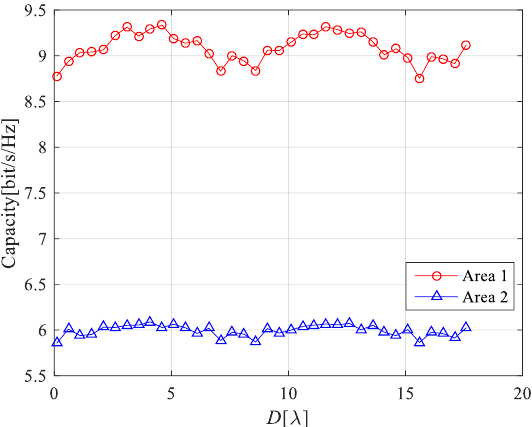
Figure 11. Channel capacity of the LCX-MIMO system for LoS only path.